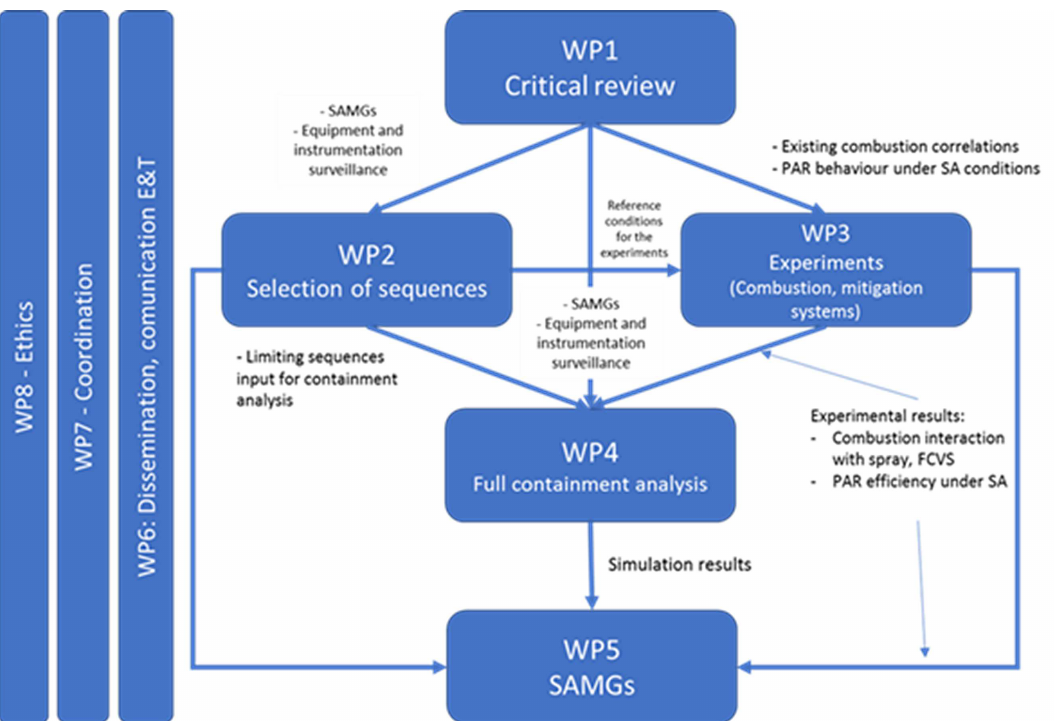
Fig. 8. AMHYCO project